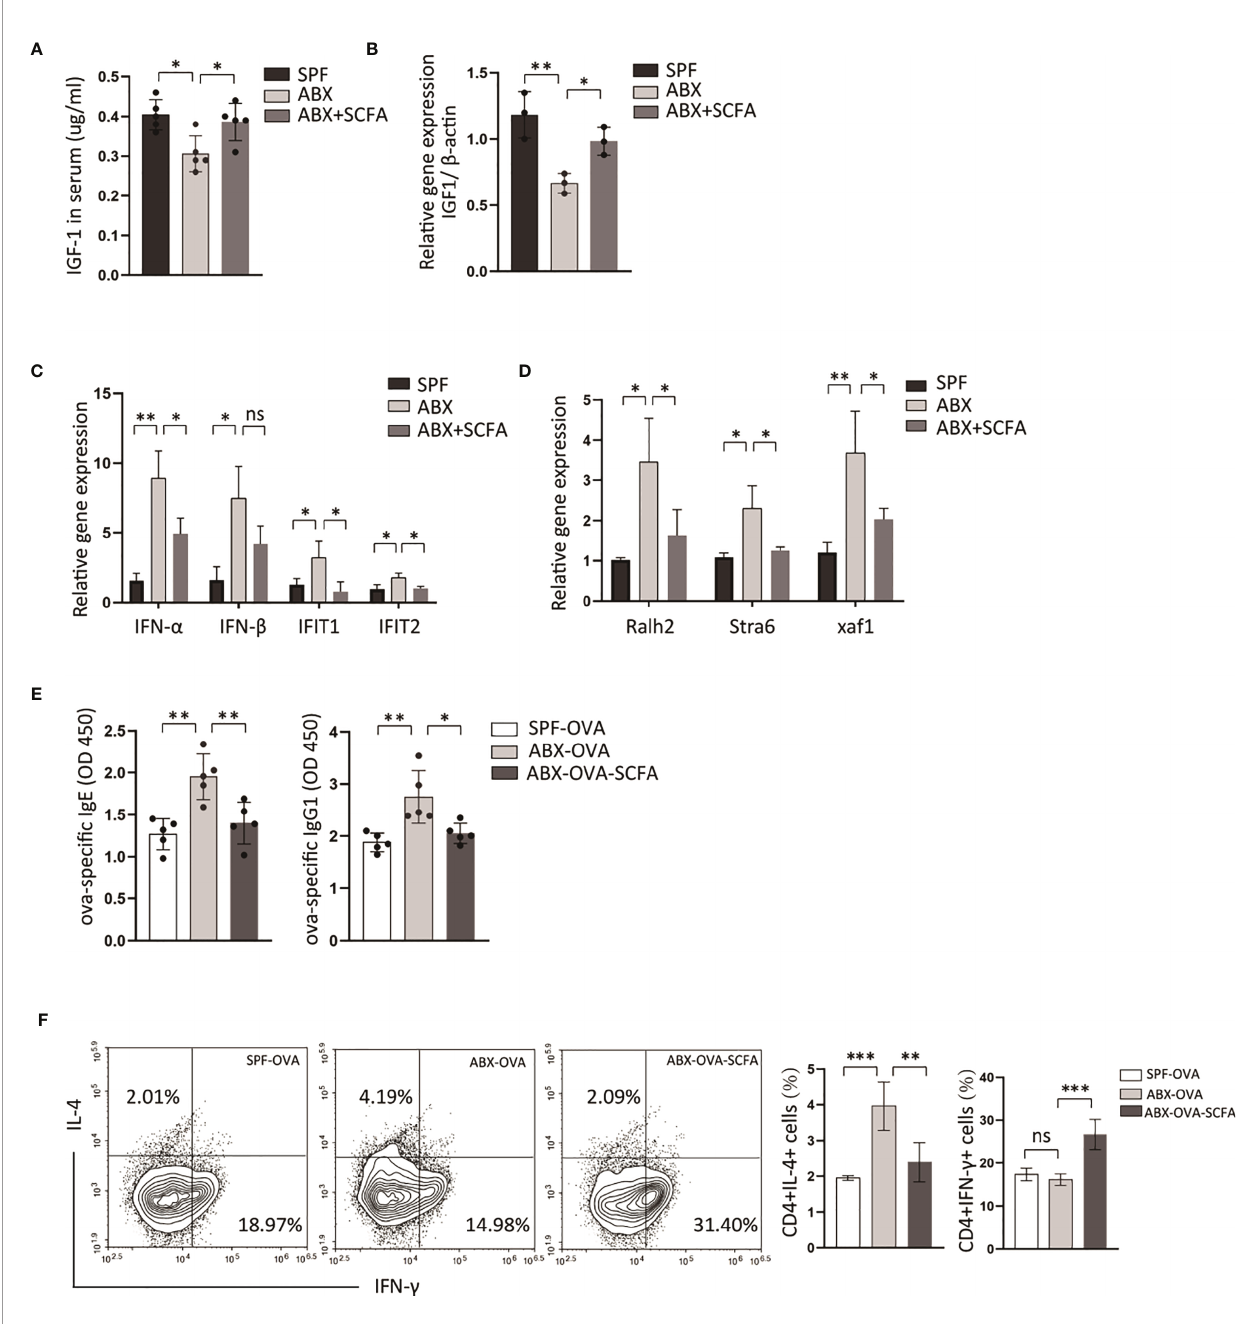
FIGURE 6 | SCFAs alleviate OVA-sensitization fueled by microbiota-dysbiosis. B6 Mice were treated with control vehicle, ABX alone, or with SCFA supplement. (A) And then the expression levels of IGF-1 in serum were detected by ELISA. (B) The transcriptional levels of IGF-1 in mLN were measured by RT-PCR. The transcriptional levels of type I interferons genes (C) and retinoic acid related genes (D) in mLN tissue were measured by RT-PCR. Then we established ova- allergic mice model fuled by microbiota dysbiosis with ABX treatment, and SCFAs were used to treat these mice. (E) The ova-speci fi c IgE and IgG1 in serum were detected by ELISA. (F) The proportions of CD4(+)IL4(+), CD4(+)IFN- g (+) cell were detected by fl ow cytometry. Graph shows mean and SEM. Data were analyzed by one-way ANOVA. *p < 0.05, **p < 0.01, ***p < 0.001. ns, not signi fi